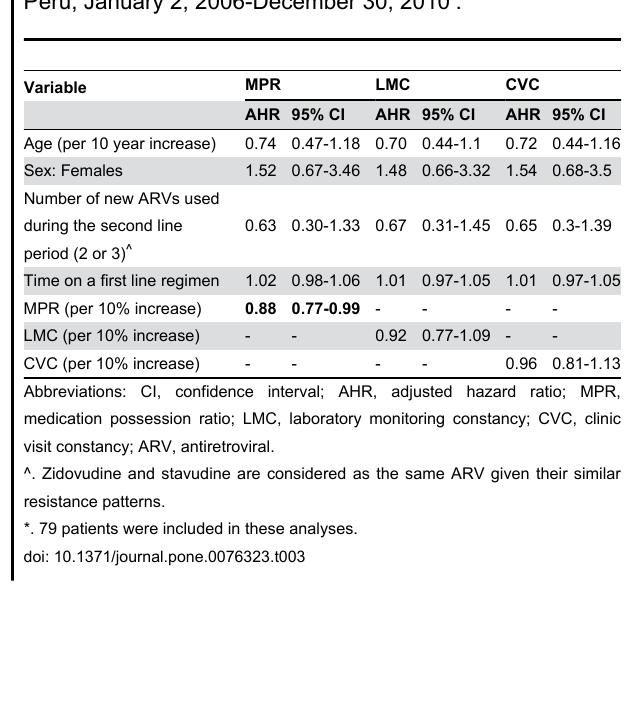
Table 3. Multivariable Cox PH analyses of factors associated with time until virologic failure on a second line regimen at Hospital Nacional Cayetano Heredia in Lima, Peru; January 2, 2006-December 30, 2010 *